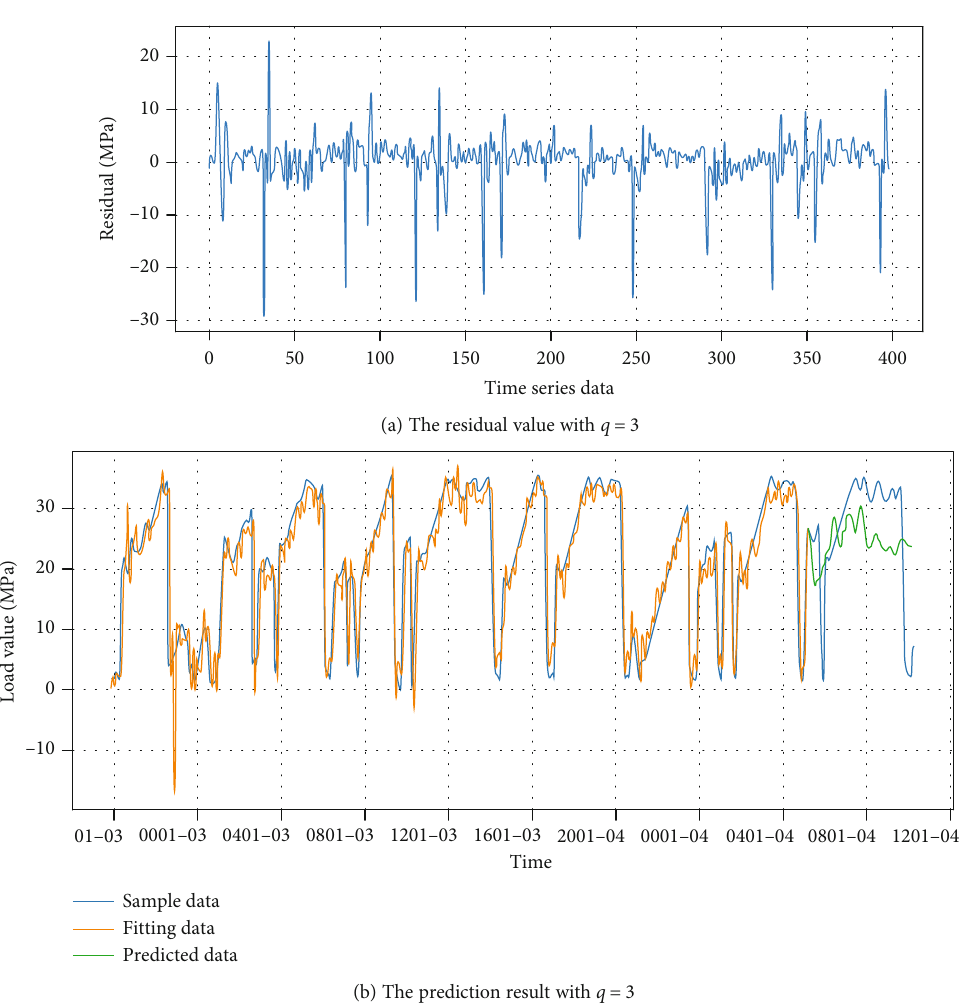
Figure 10: The model ’ s residual value and prediction result with q = 3